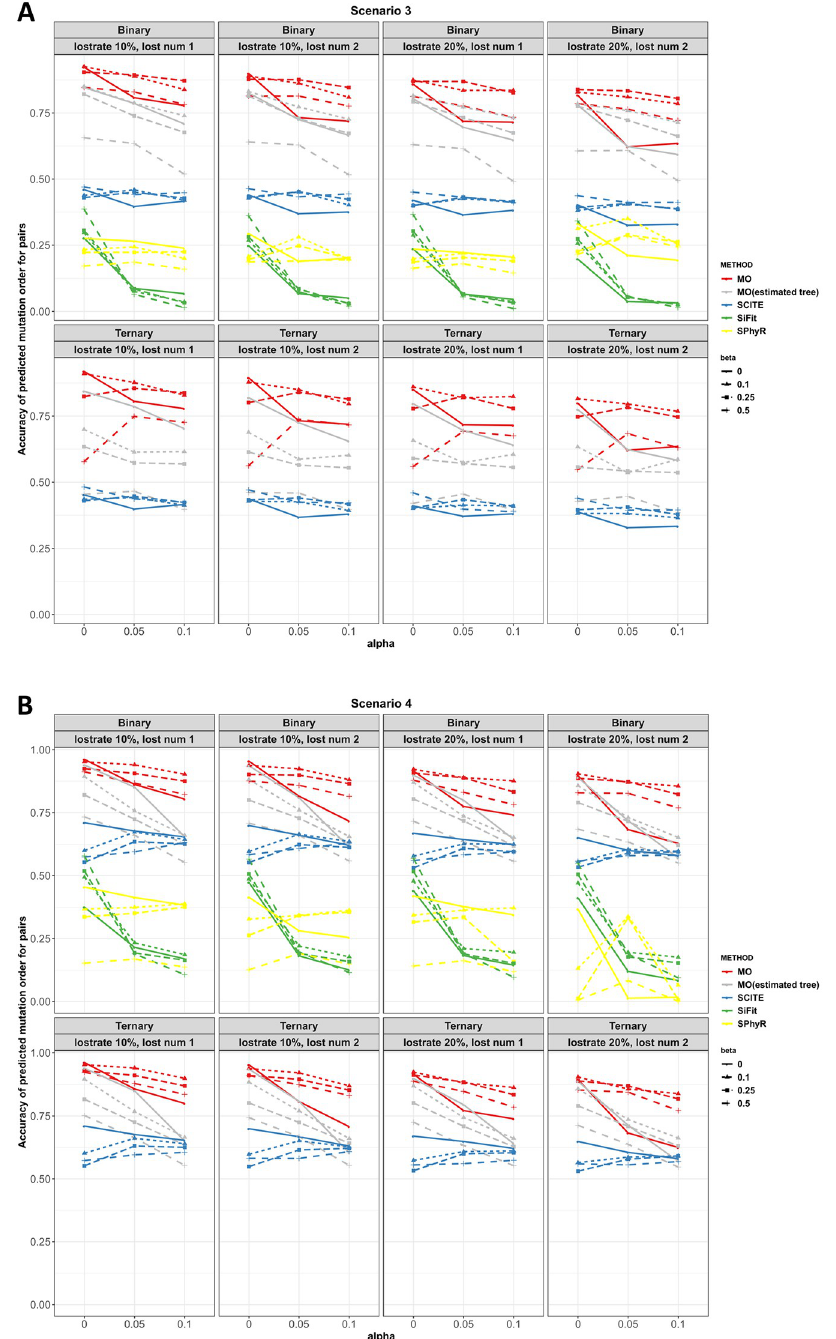
Fig 6. Order accuracy in scenarios 3 and 4 for MO, SCITE, SiFit and SPhyR when there are 20 mutations. Each panel includes the results from the specific type of genotype and lost mutations. In each panel, red, gray, blue, green and yellow colors correspond to MO with the true tree, MO with the estimated tree, SCITE, SiFit and SPhyR, respectively. Each plotting symbol on the line represents a different β . The x-axis is the probability of an error, α , and the y-axis is order